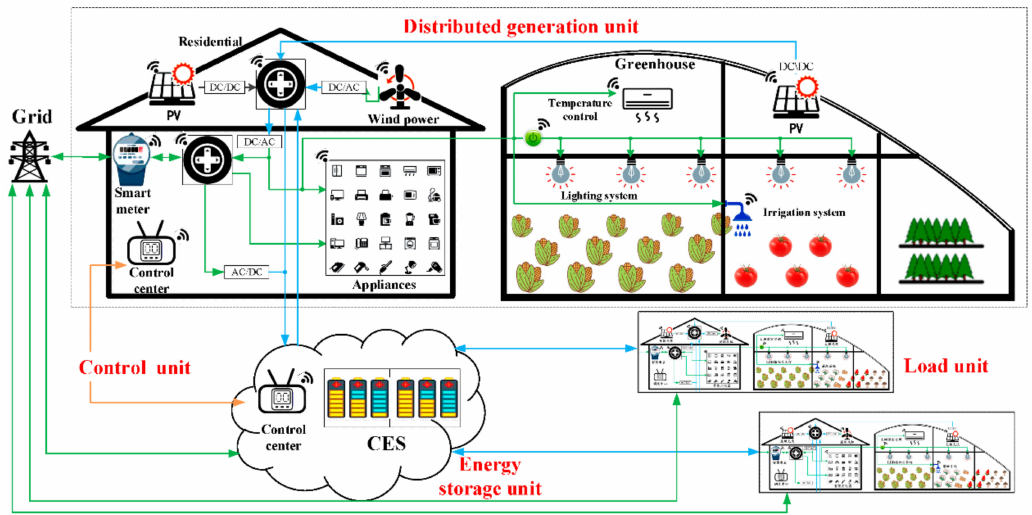
Figure 1. Rural microgrid architecture based on cloud energy storage